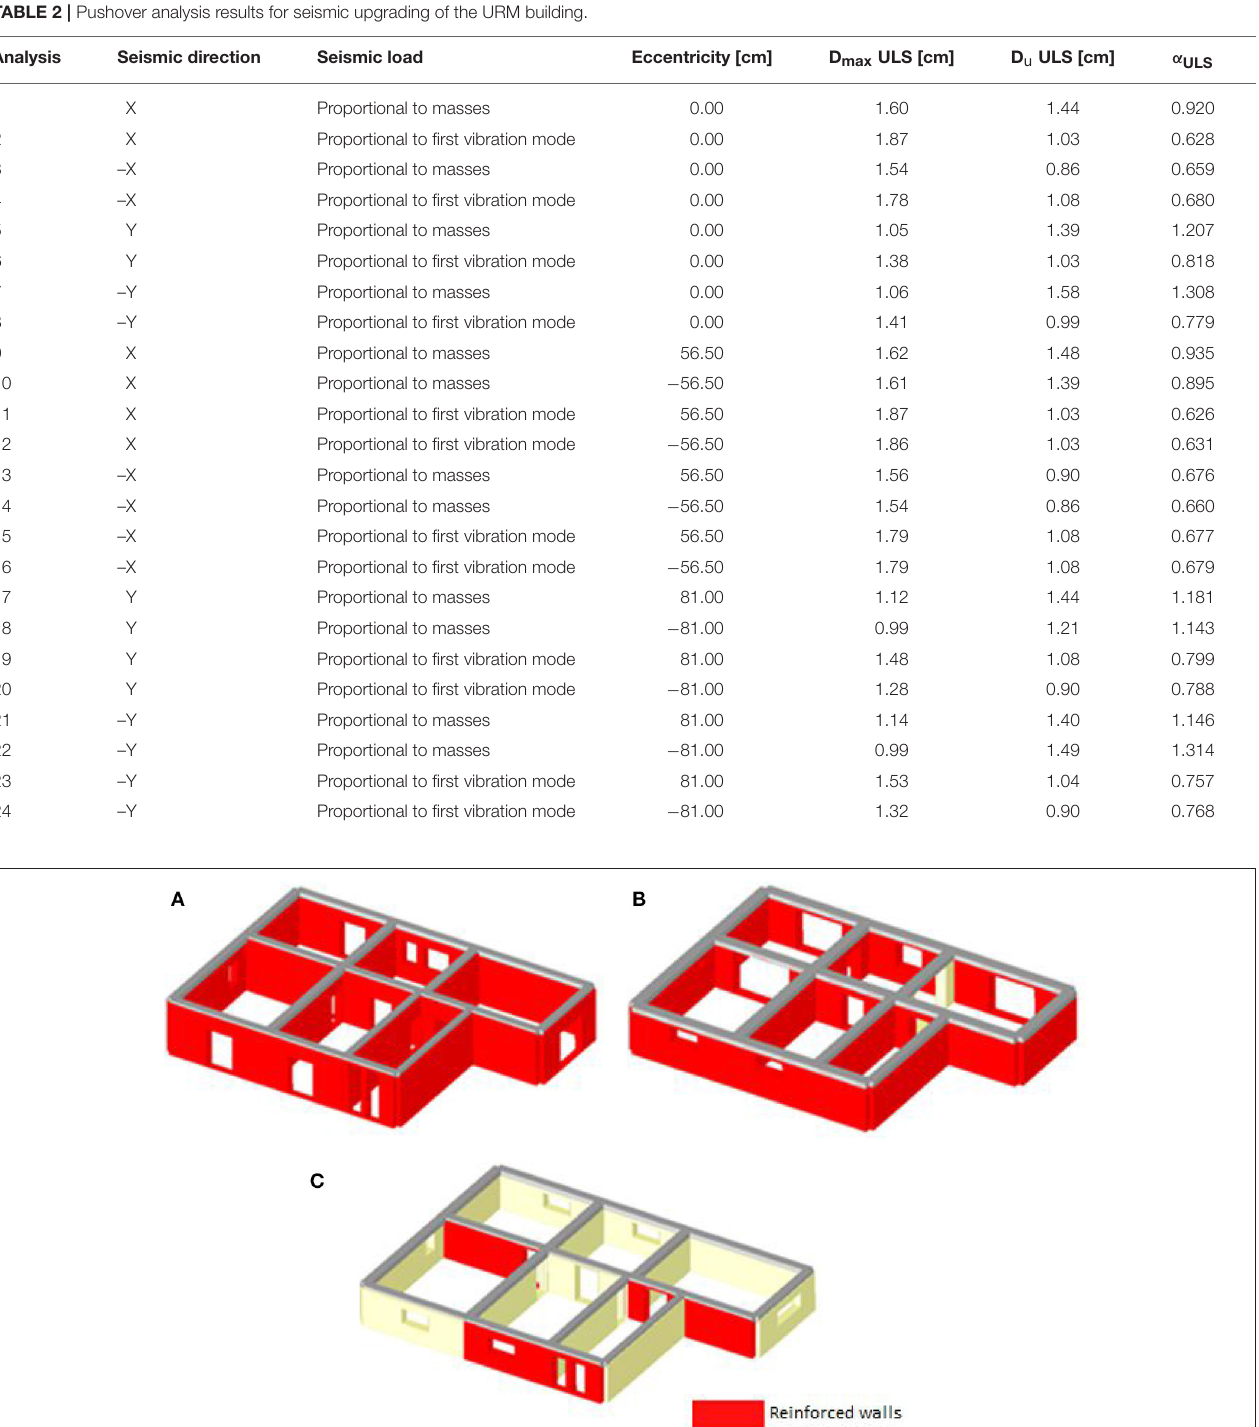
Frontiers in Built Environment |